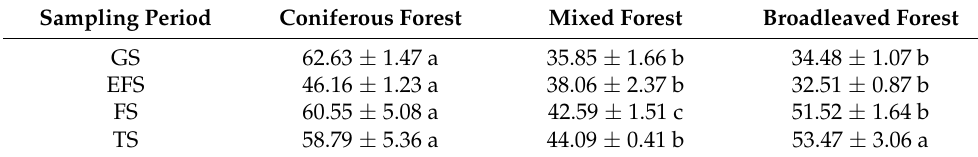
Figure 2. Content of litter carbon input of three forests at different critical sampling periods ( a ), cumulative litter carbon input during the experiment ( b ), and percentage of carbon input of each litter component ( c ). GS: growing season, EFS: early freezing season, FS: freezing season, TS: thawing season. Error bars mean standard error, different lowercase letters indicate significant differences between different forest types. Table 3. Ratio of carbon to nitrogen of litter input at each sampling period of three forest types.